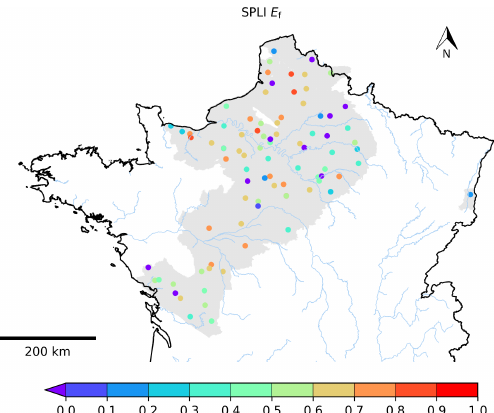
Figure 9. E f criterion calculated between the observed and simu- lated SPLI for the 103 selected